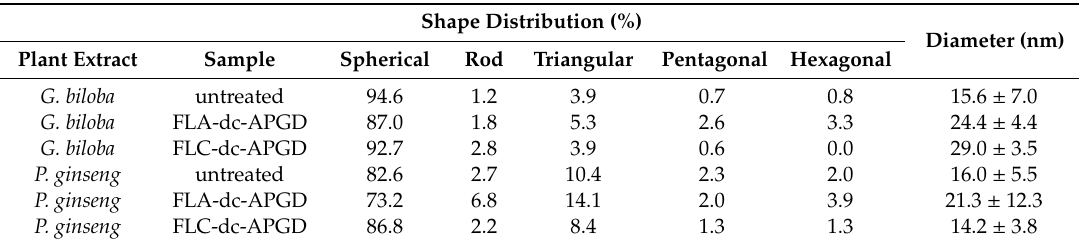
Table 2. The summary of the shape and size distribution determined for AuNPs synthesized using untreated, FLA-dc-APGD-activated or FLC-dc-APGD-activated aqueous plant extracts. The concentration of the Au (III) ions used in the reaction mixture was 500 mg L − 1 . Shape Distribution (%) Diameter (nm) Plant Extract Sample Spherical Rod Triangular Pentagonal Hexagonal G.